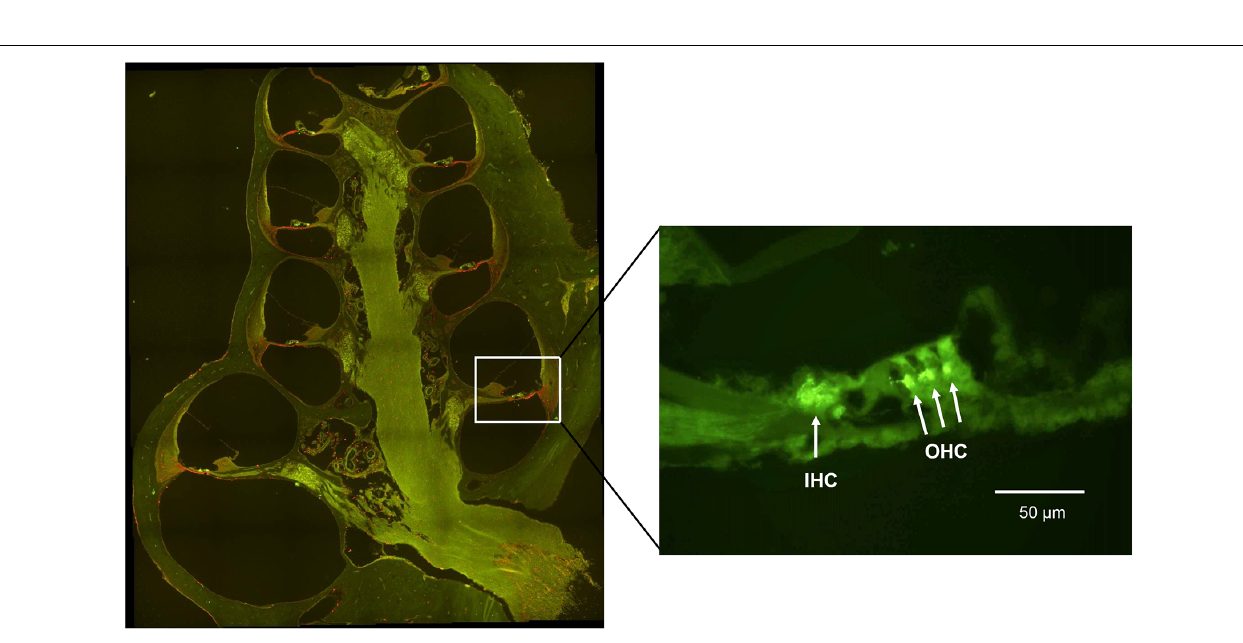
2 weeks after noise exposure followed by H 2 inhalation in order to follow the electrophysiological and morphological changes at different time points after